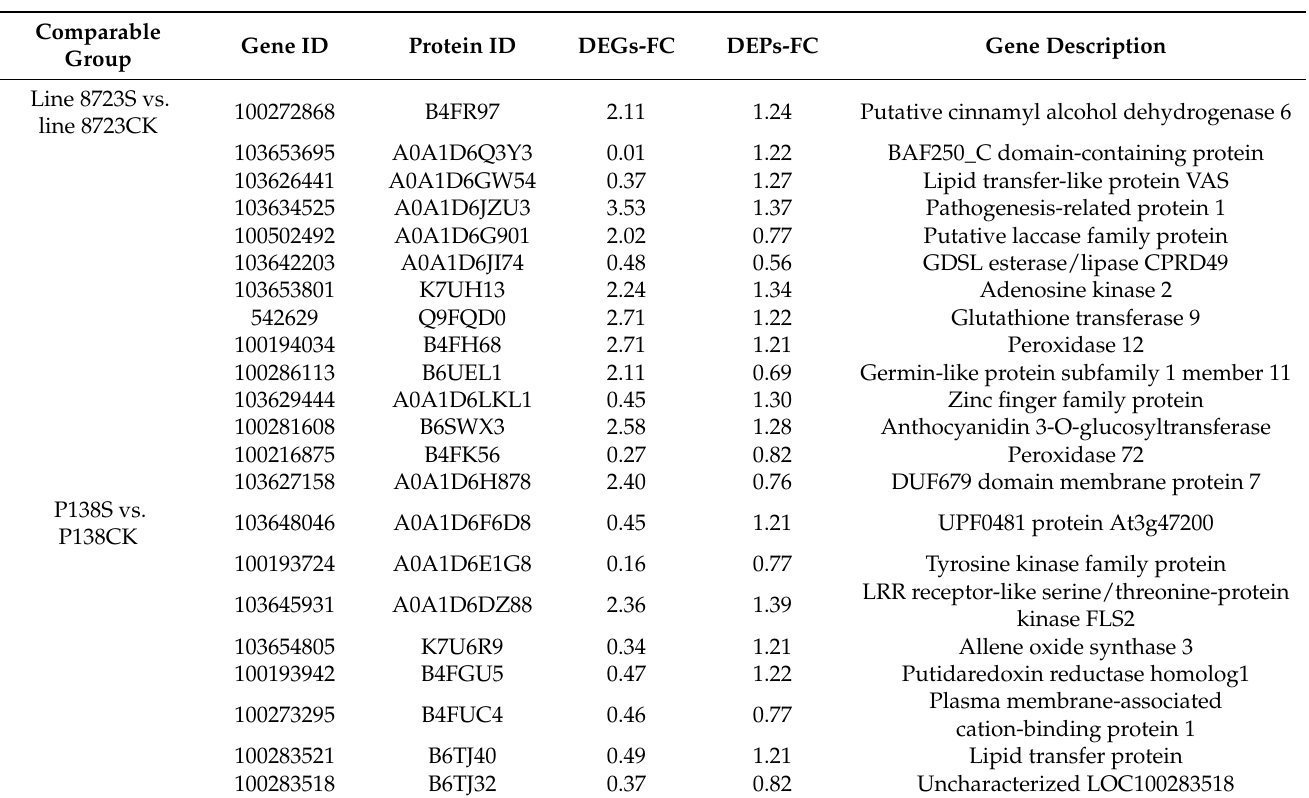
Table 1. Results of the correlation analysis between the DEPs and DEGs of two inbred lines under salt stress.